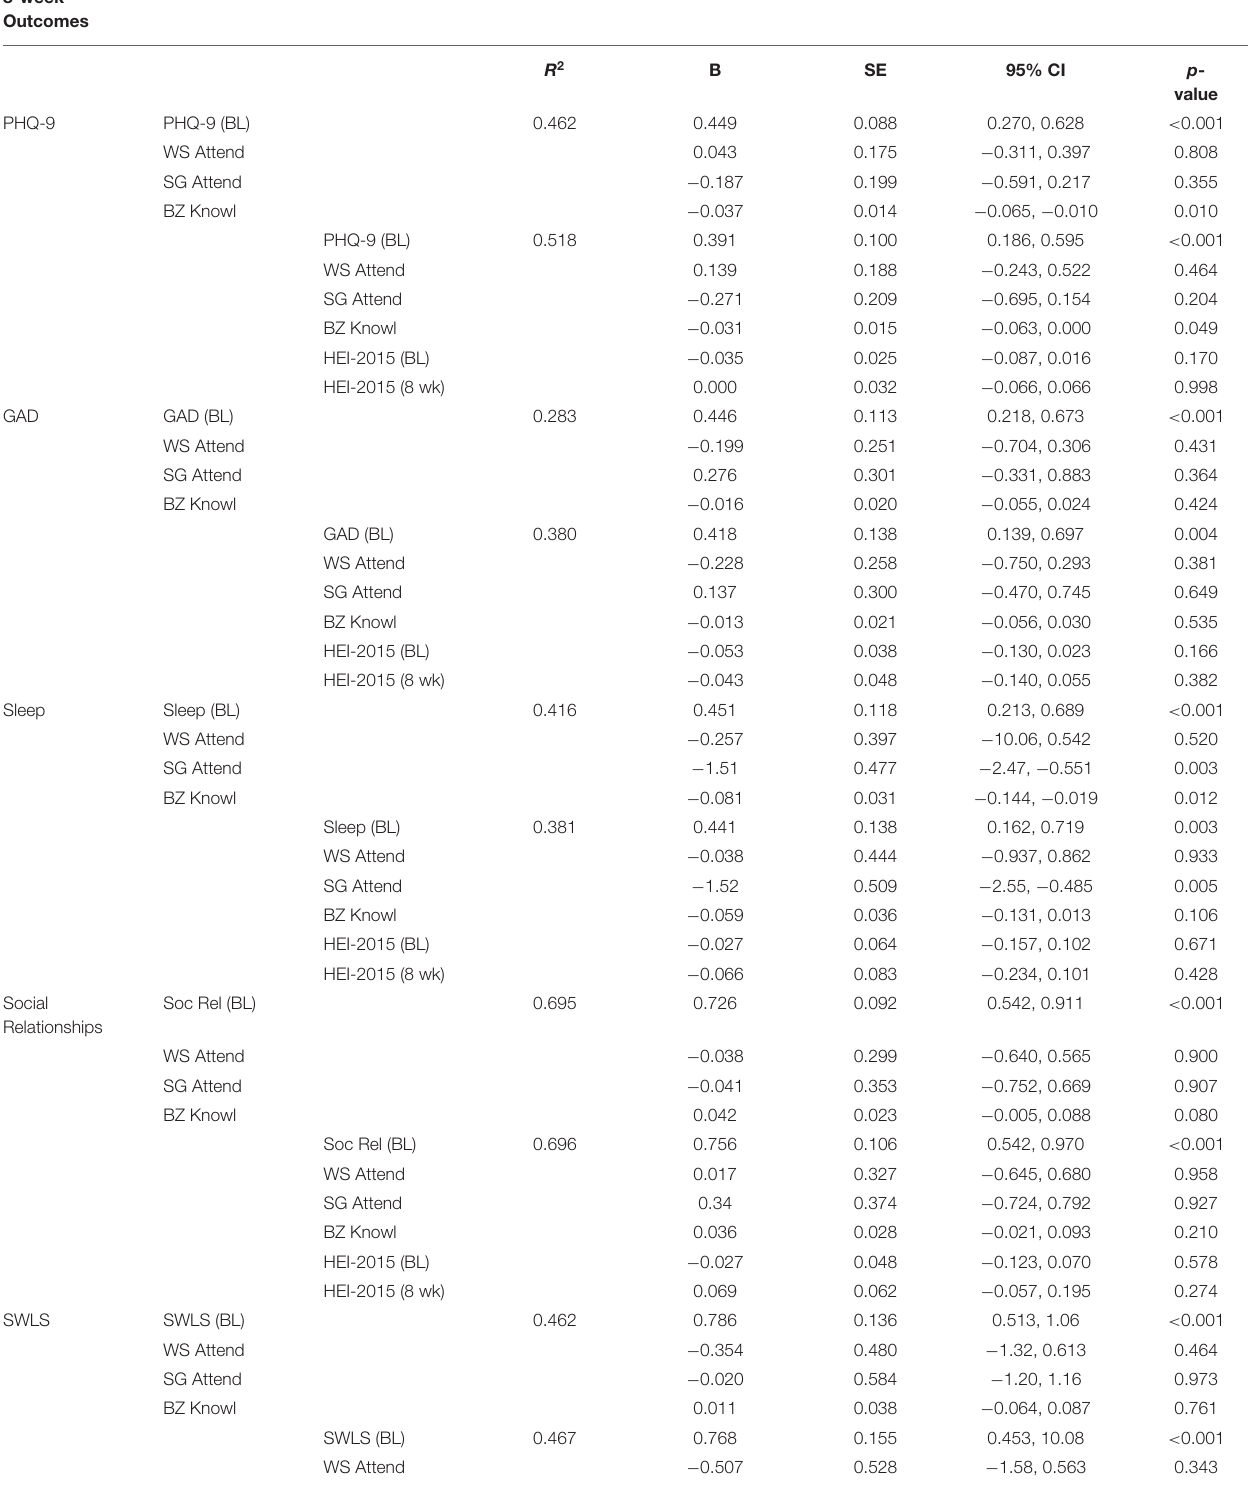
TABLE 3 | Linear regression associations between attendance at workshops, attendance in small group sessions, Blue Zones knowledge, HEI-2015 scores and baseline mental wellness scores with mental wellness outcomes at 8-weeks post-intervention among all participants in Blue Zones-based worksite intervention ( n = 52). 8-week